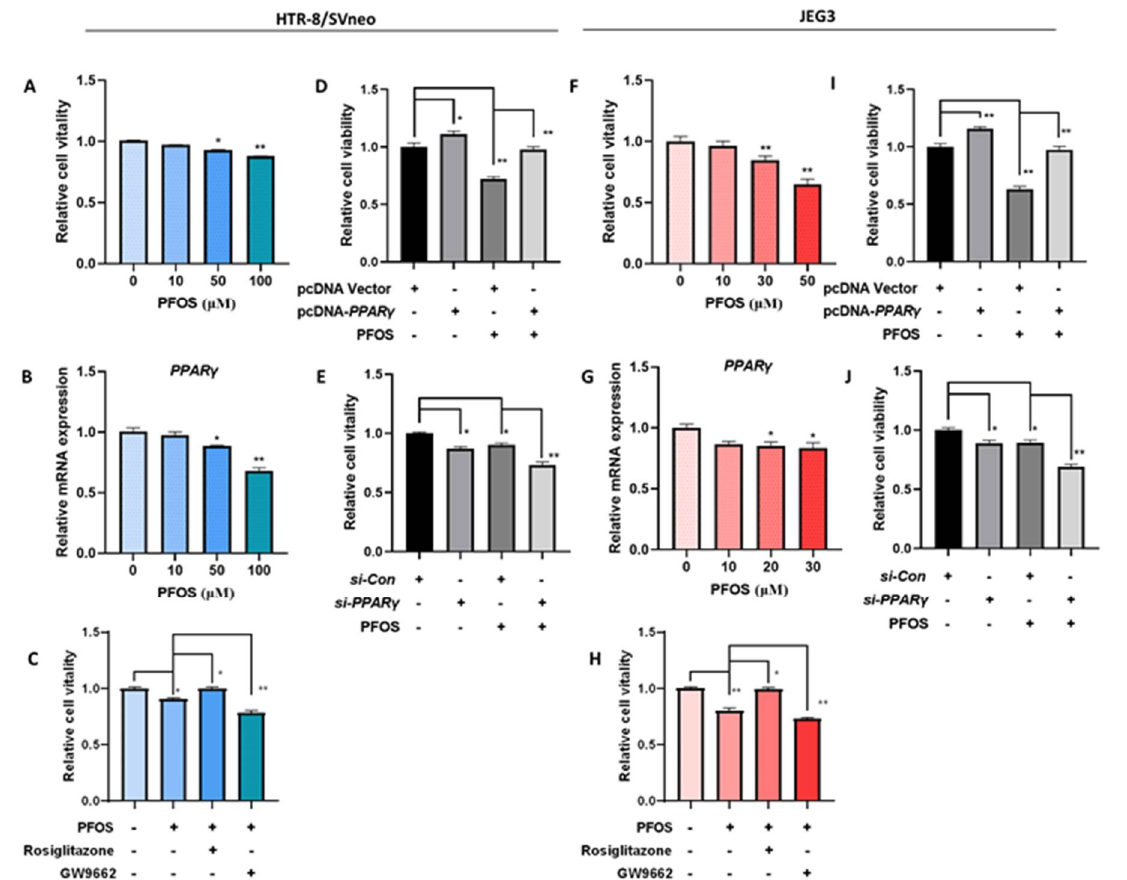
Figure 1. Effect of PPAR γ on proliferation exposed to PFOS in vitro (50 µ M for HTR-8/SVneo, 30 µ M for JEG-3). Cell vitality was detected by CCK-8 assay in ( A ) and JEG-3 ( F ) cells exposed to PFOS for 24 h. Relative mRNA expression levels of PPAR γ were analyzed by RT-PCR in the two cell lines ( B , G ) exposed to PFOS for 24 h. Cell growth of HTR-8/SVneo ( C ) and JEG-3 cells ( H ) were then checked with PFOS treatment in the absence or presence of rosiglitazone and GW9662, and also estimated with treatment of PFOS when PPAR γ was overexpressed and knocked down in HTR-8/SVneo ( D , I ) and JEG-3 cells ( E , J ). The data are shown as the means ± S.E.M. * p < 0.05; ** p < 0.01; compared with the indicated group, n = 3.